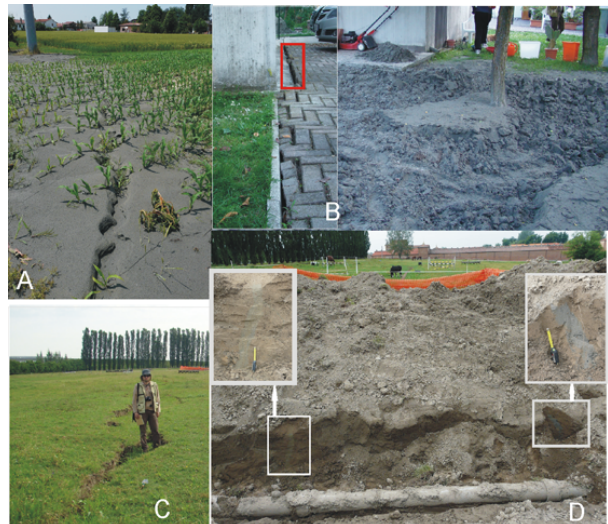
Fig. 3. Vent fractures with ejected sandy material (a) , sandy material covering the courtyard of a settled and shifted house (b) , surface ruptures (c) , evidence of a penetration of a clayey cap layer by a sandy material (d)